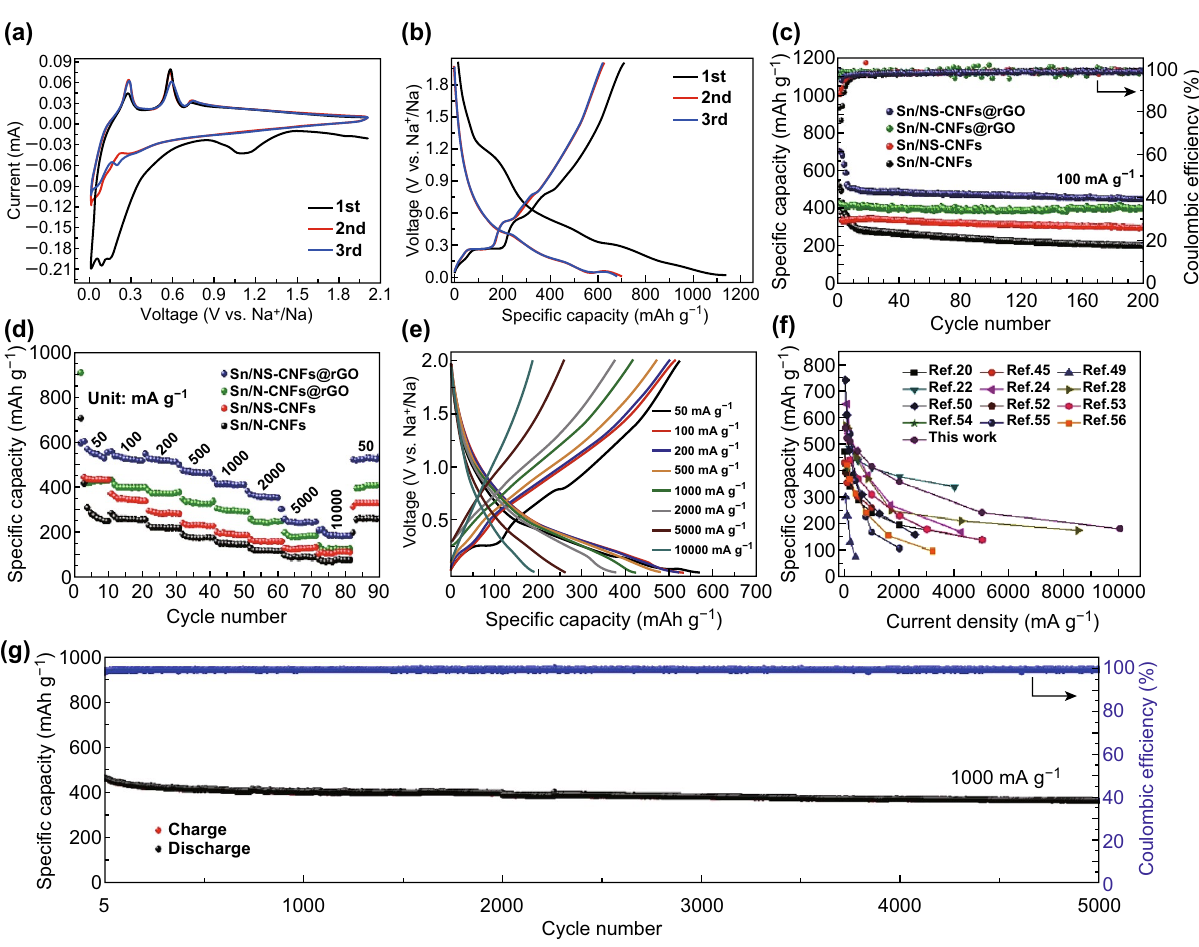
Fig. 4 a Cyclic voltammograms for the first three cycles of a Sn/NS‑CNFs@rGO electrode at a scanning rate of 0.2 mV s −1 . b The first three galvanostatic discharge/charge voltage profiles of a Sn/NS‑CNFs@rGO electrode at 100 mA g −1 . c Cycling performance of Sn/N‑CNFs, Sn/ NS‑CNFs, Sn/N‑CNFs@rGO, and Sn/NS‑CNFs@rGO electrodes at a current density of 100 mA g −1 in the voltage range of 0.01–2.0 V vs Na +